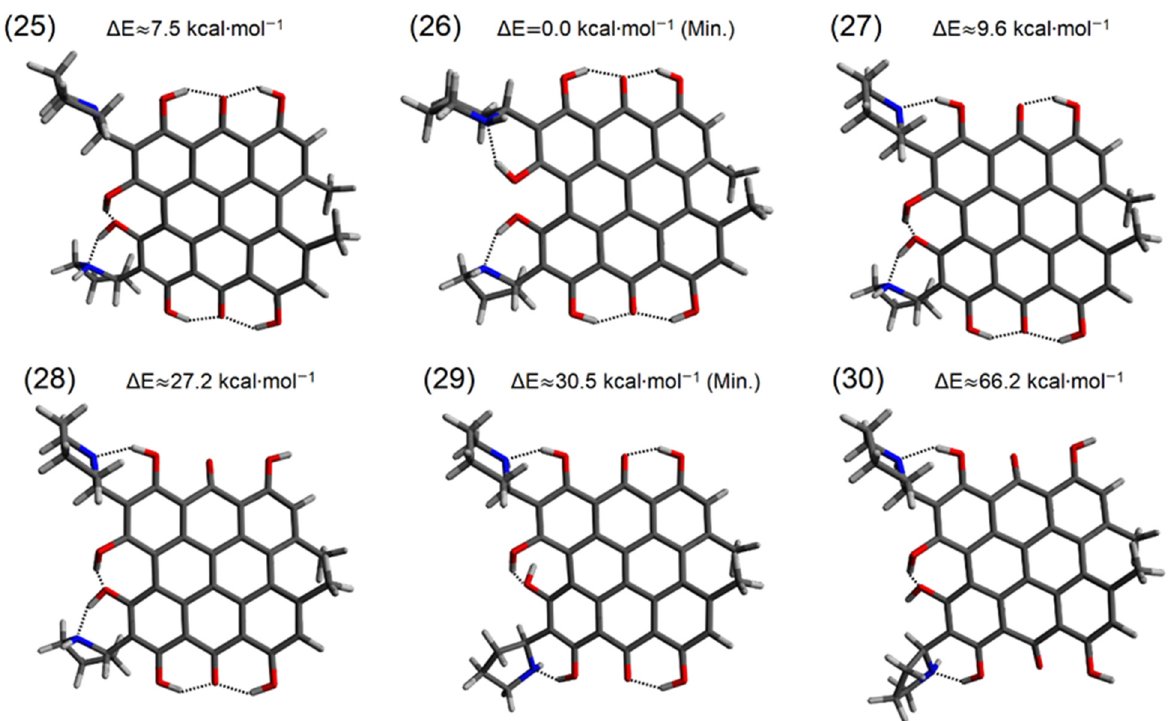
Figure 5. Conformers (25–30) of fagopyrin E.